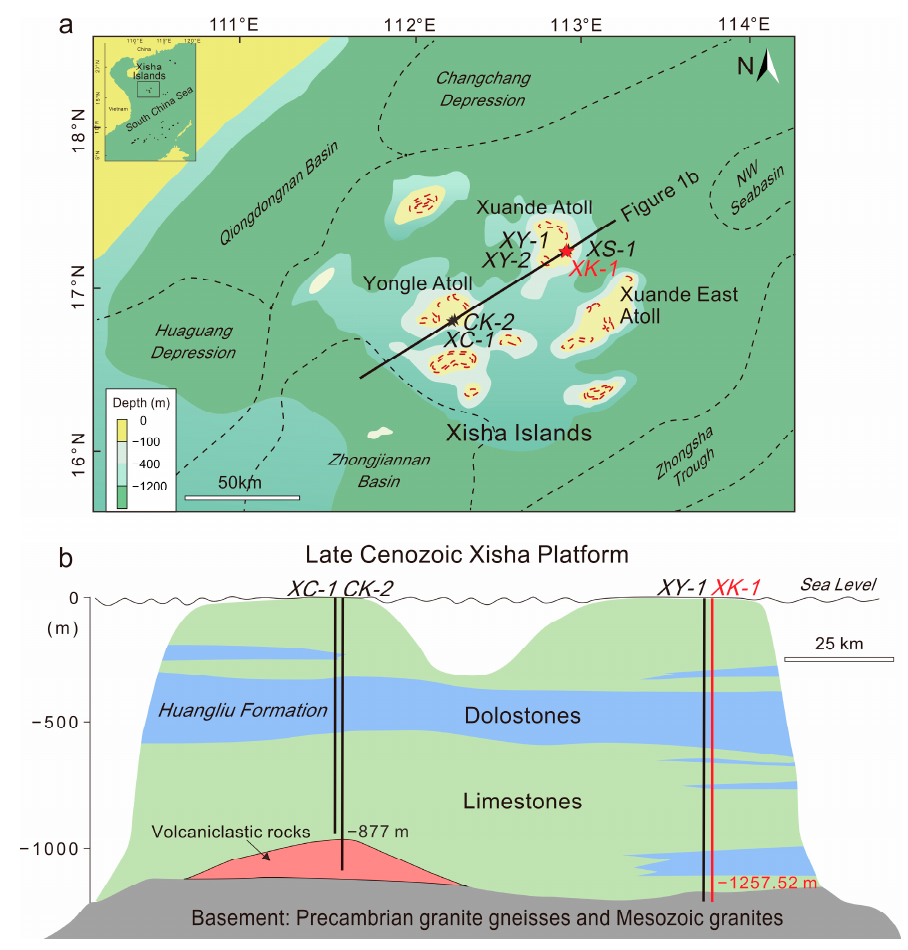
Figure 1. ( a ) Location of the Xisha Islands in the South China Sea, and distribution of wells. ( b ) Cross-section through the Xisha carbonate platform. See Figure 1a for the location. Figures are modified from [18,21].